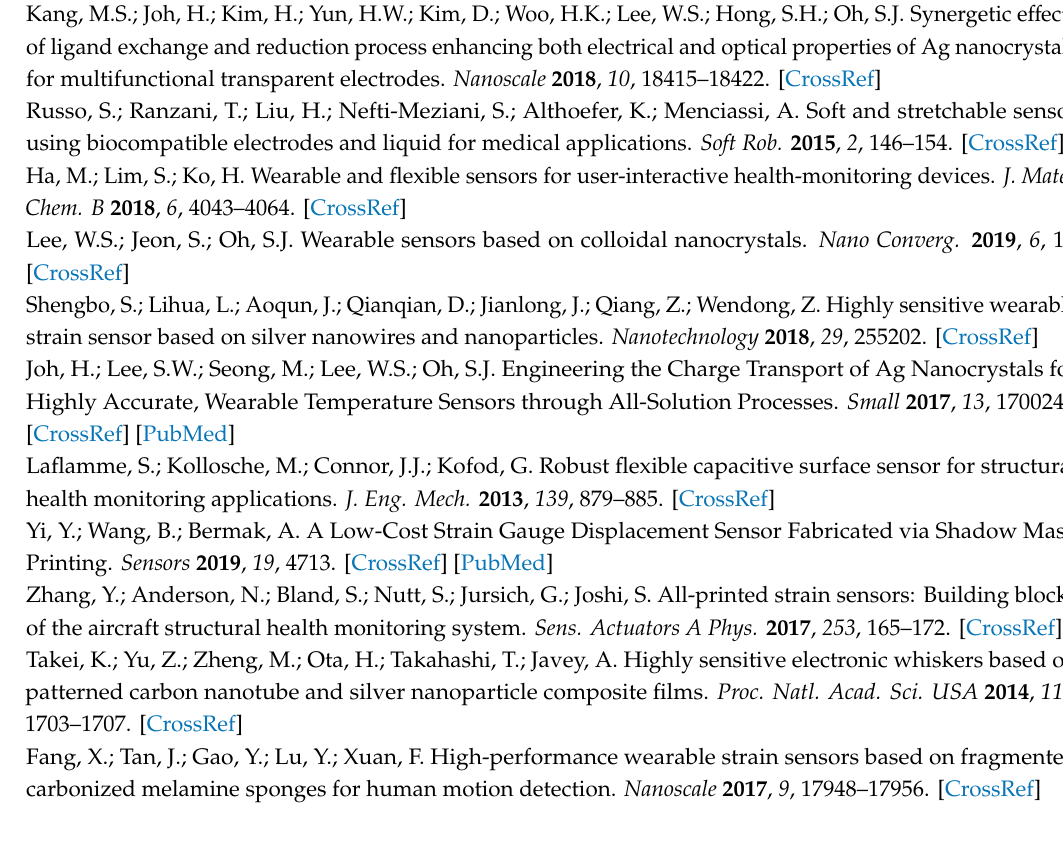
Figure S1: Variation in the Sensors’ GFs for uncoated as well as alumina coated sensors, before and after Fatigue experiments. Figure S2: Resistance variance for sensors under fixed strain (strain values of 0%, 0.3%, 0.6%, 0.9% and 1.2%), in a varying humidity environment. R.H. varies between 10% and 70%. Figure S3: Relative resistance change over time. Sensors’ resistance was measured after one day, one month and three months for sensors without alumina coating (uncoated) and with 5 nm and 11 nm alumina